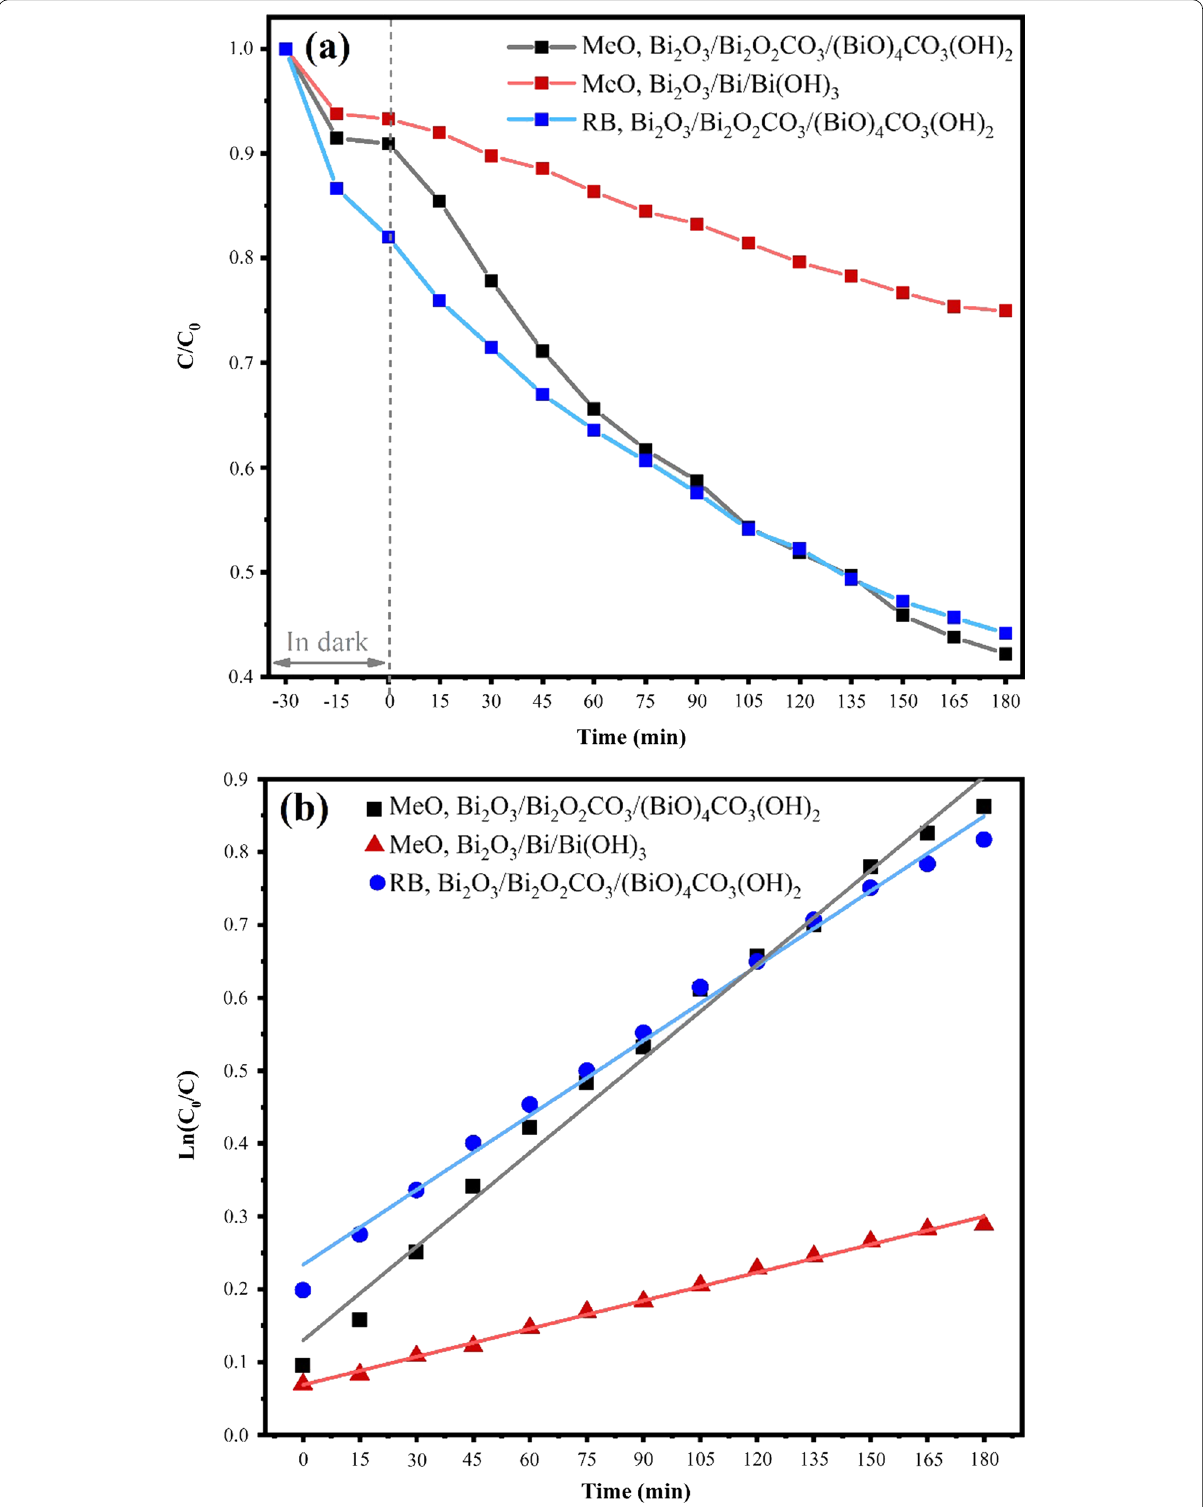
Fig. 7 a Photocatalytic degradation of dyes and b Liner curves of ln( C / C 0 ) versus the irradiation time for the photodegradation reaction kinetics of dyes by